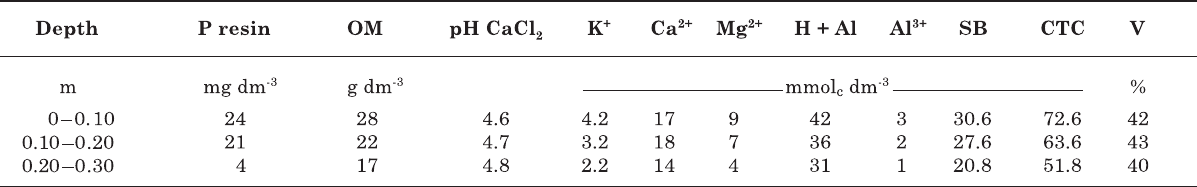
Table 1. Soil chemical analysis of the layers 0–0.10; 0.10–0.20 and 0.20–0.30 m at soybean sowing in the experimental area (average of 30